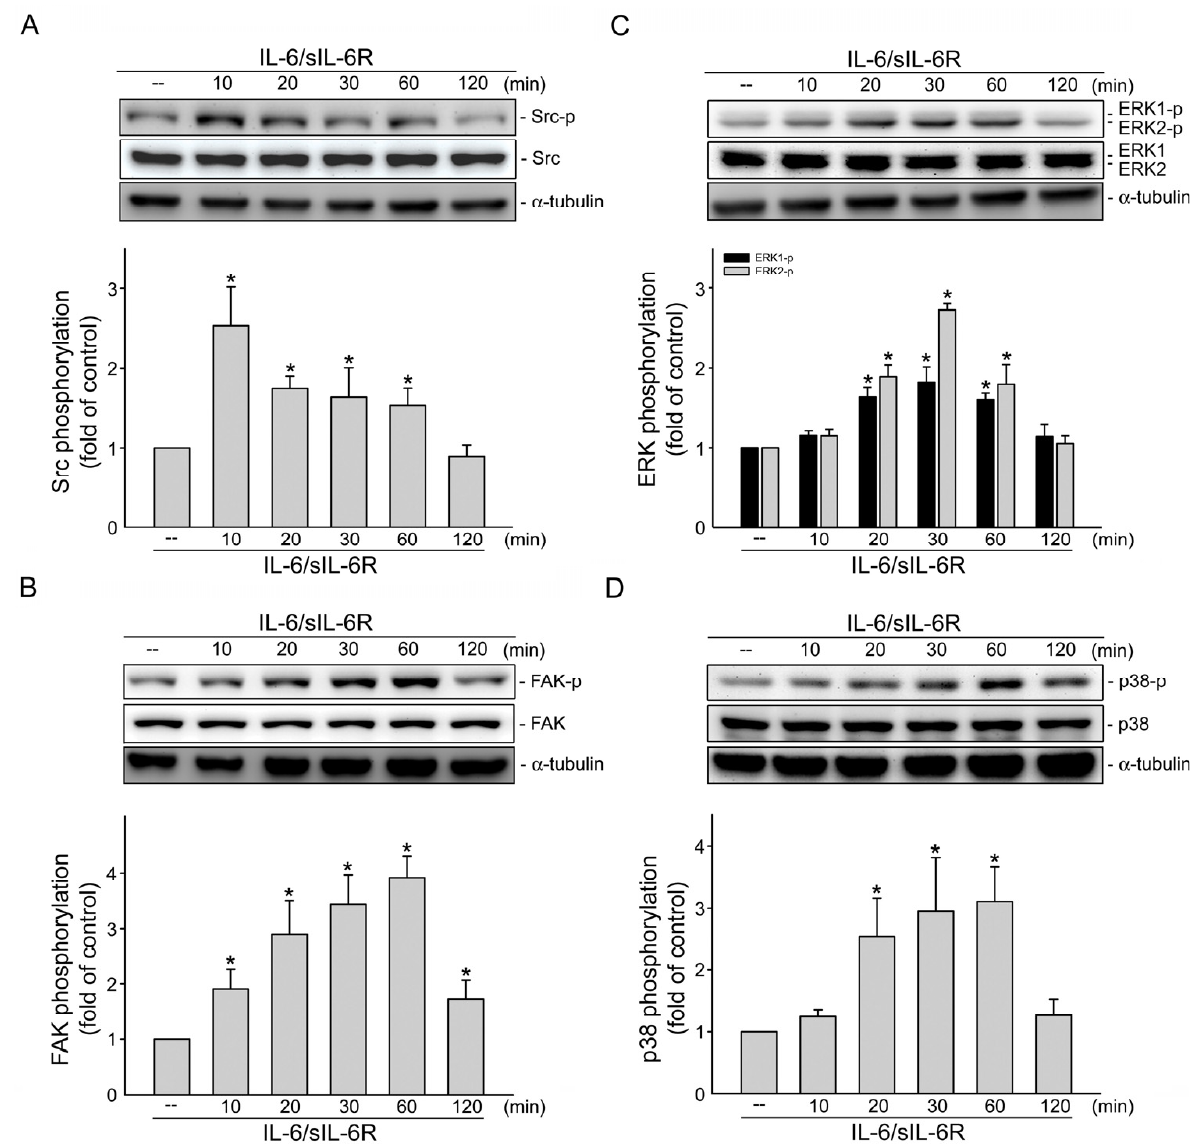
Figure 3. Src, FAK, ERK1/2 and p38MAPK phosphorylation were increased in IL-6/sIL-6R-stimulated HCT116 cells. HCT116 cells were stimulated by IL-6/sIL-6R (20 ng/mL) for different time periods as indicated. Immunoblotting was employed to examine the Src ( A ), FAK ( B ), ERK1/2 ( C ) and p38MAPK ( D ) phosphorylation status. Bar graph represents the mean ± S.E.M. of five independent experiments. * p < 0.05, compared with the control group.